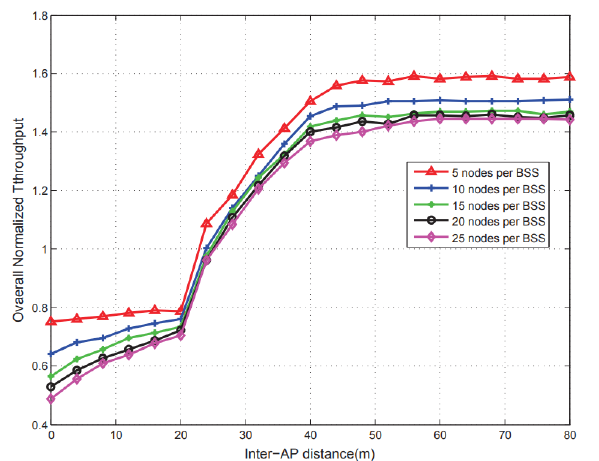
Figure 1 . Overall normalized throughput vs. inter-AP distance